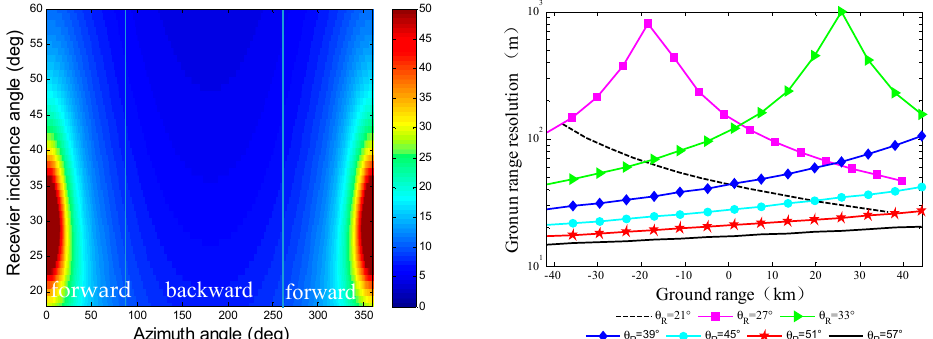
Figure 5. ( Left ): The ground range resolution with respect to the received azimuth angle ϕ R . ( Right ): The ground range resolution in different beams.